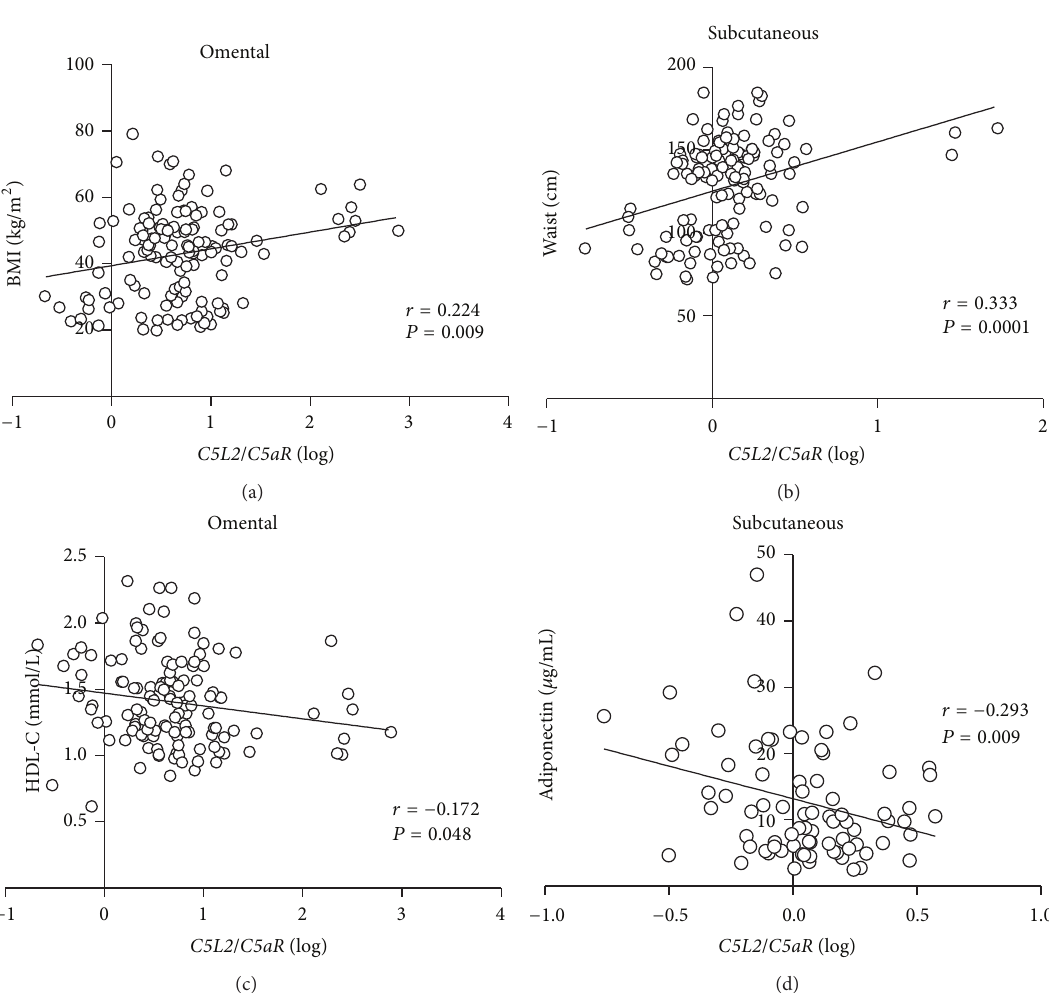
Figure 4: C5L2/C5aR ratio is associated with anthropometric indices, HDL, and adiponectin. Linear regression analysis of omental C5L2/ C5aR versus BMI (a), subcutaneous C5L2/C5aR versus waist circumference (b), omental C5L2/C5aR versus HDL-C (c), and subcutaneous C5L2/C5aR versus adiponectin (d). Reported 𝑟 and 𝑃 values were calculated by Pearson